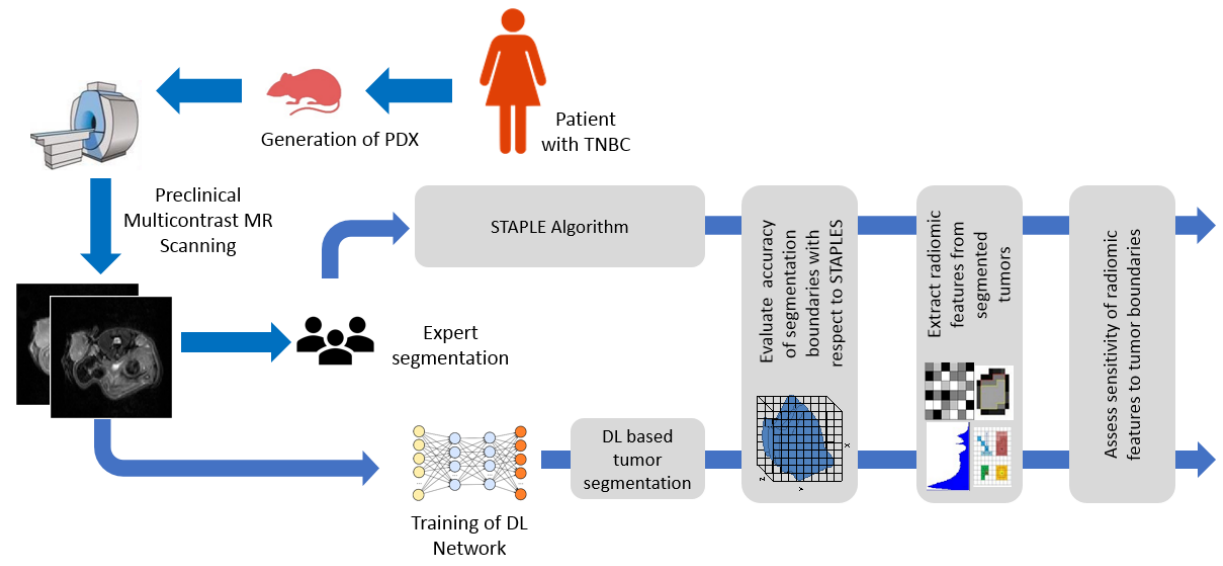
Figure 1. Overview of the pipeline of the project.